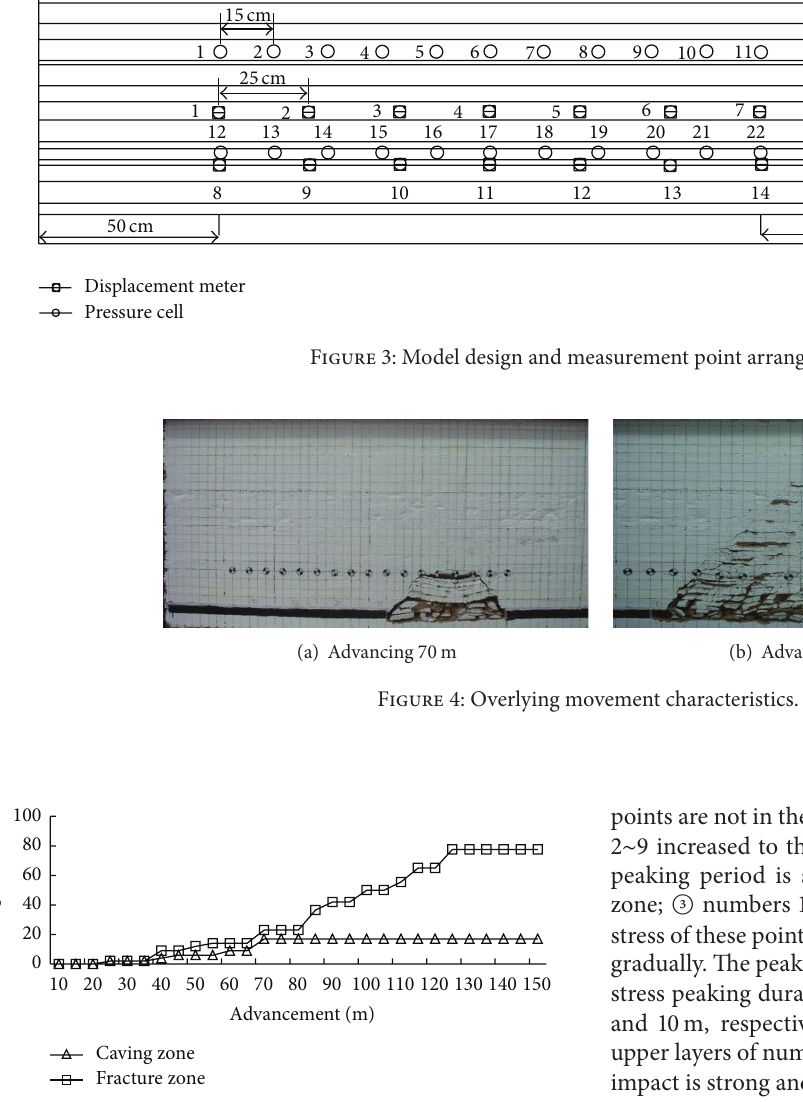
Figure 5: Height of caving zone and fractured zone along with the